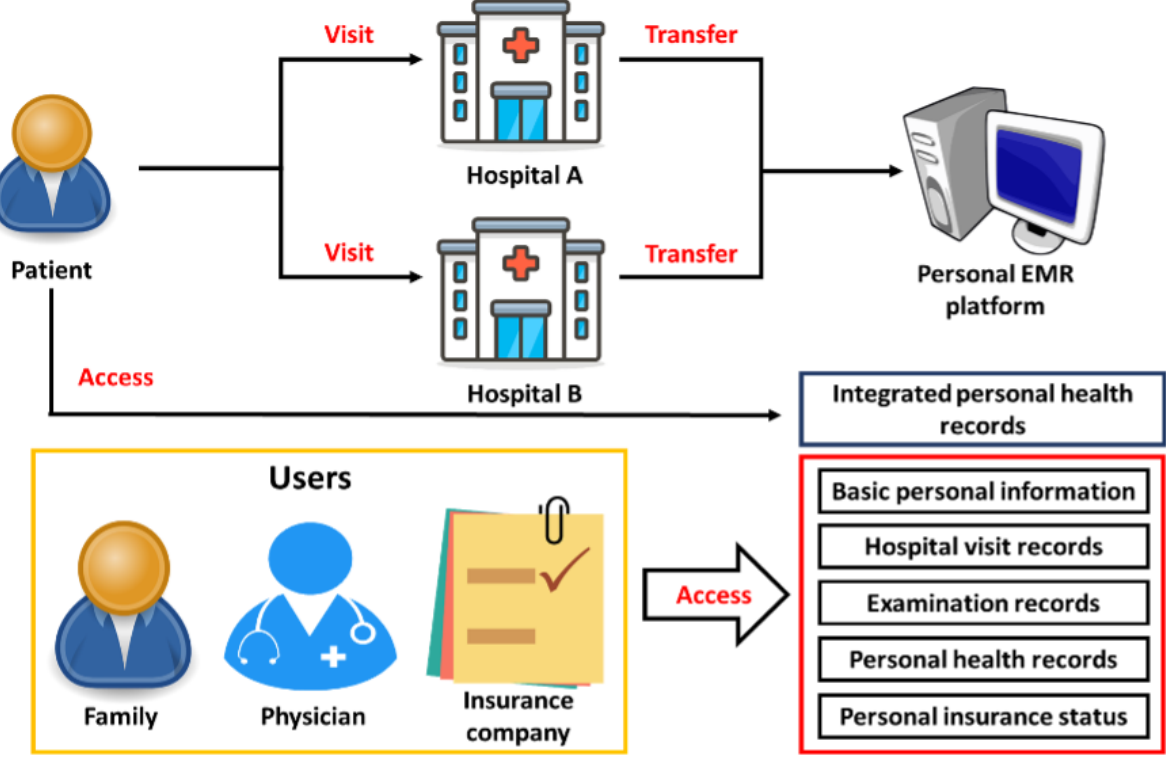
Figure 5. Schematic of My Health